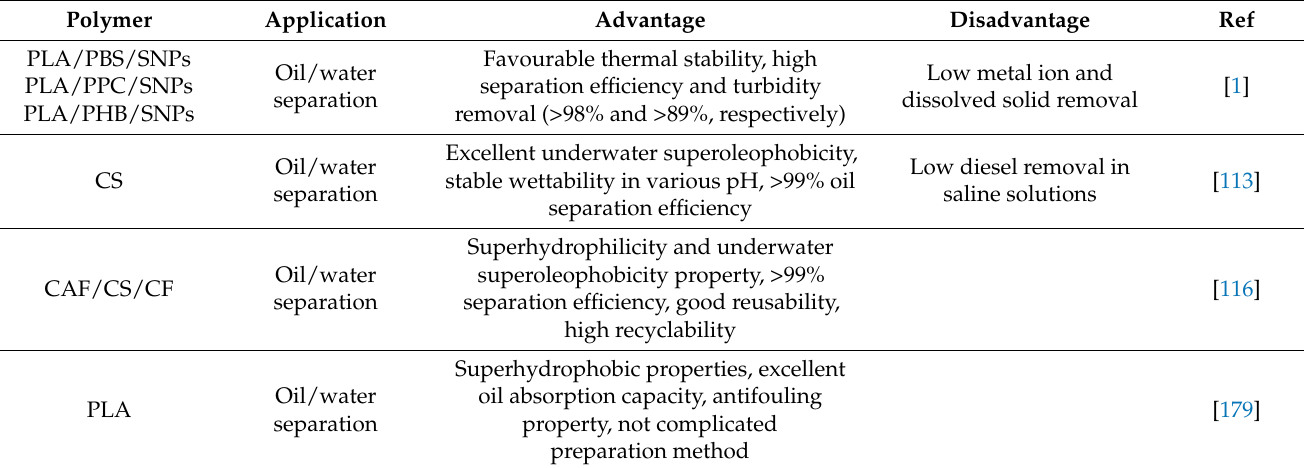
Table 2. An overview of the applications of biodegradable